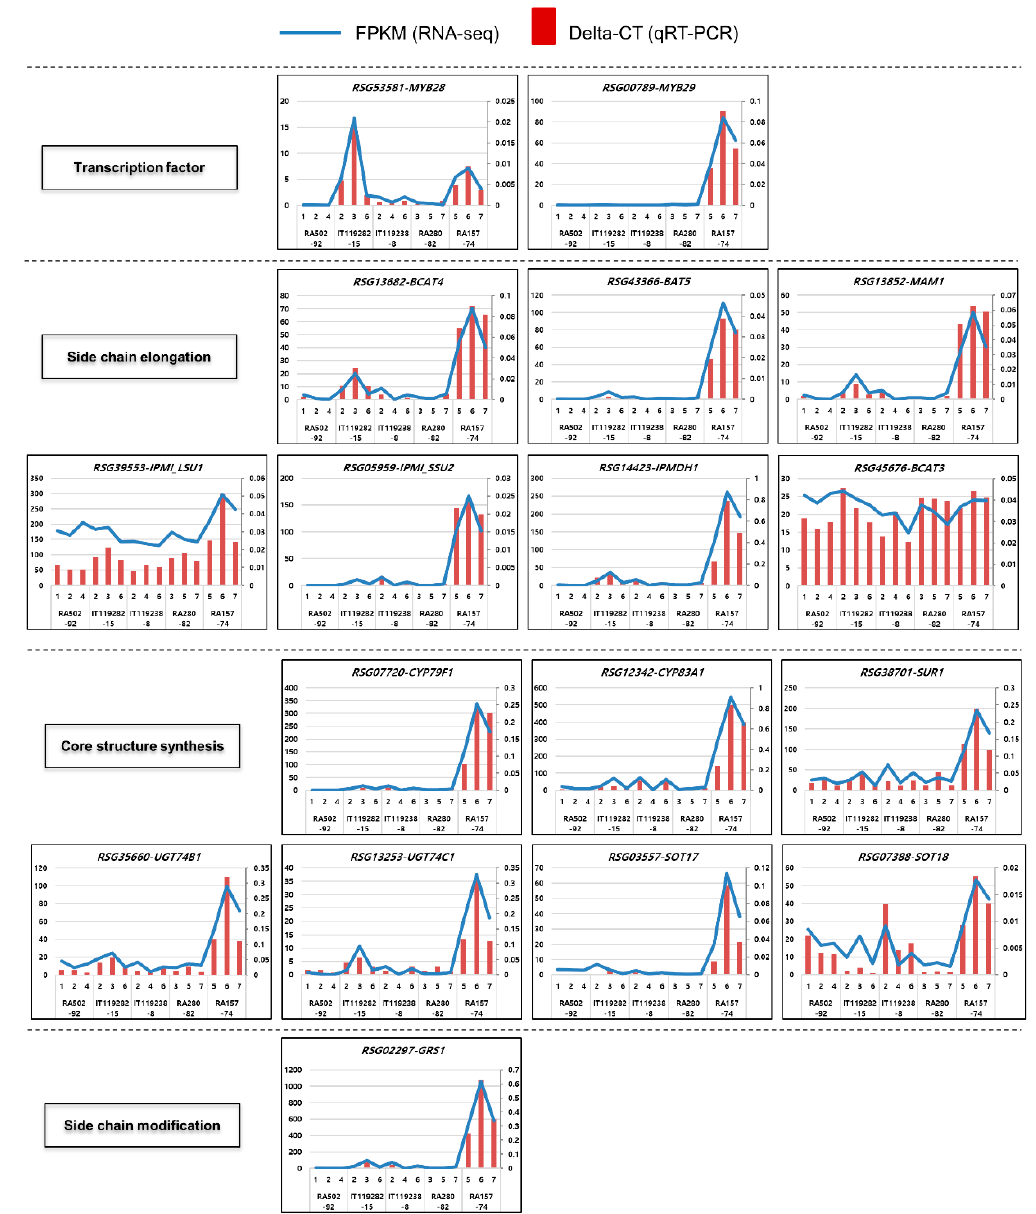
Figure 6. qRT-PCR examination of aliphatic GSL biosynthesis genes in radish roots. The GSL biosynthesis genes were analyzed by qRT-PCR, and the value was compared with the FPKM value. The blue lines represent the FPKM (left y -axis) data, and the red bars indicate the qRT-PCR data (right y -axis). The expression level of qRT-PCR was measured by the delta CT method.